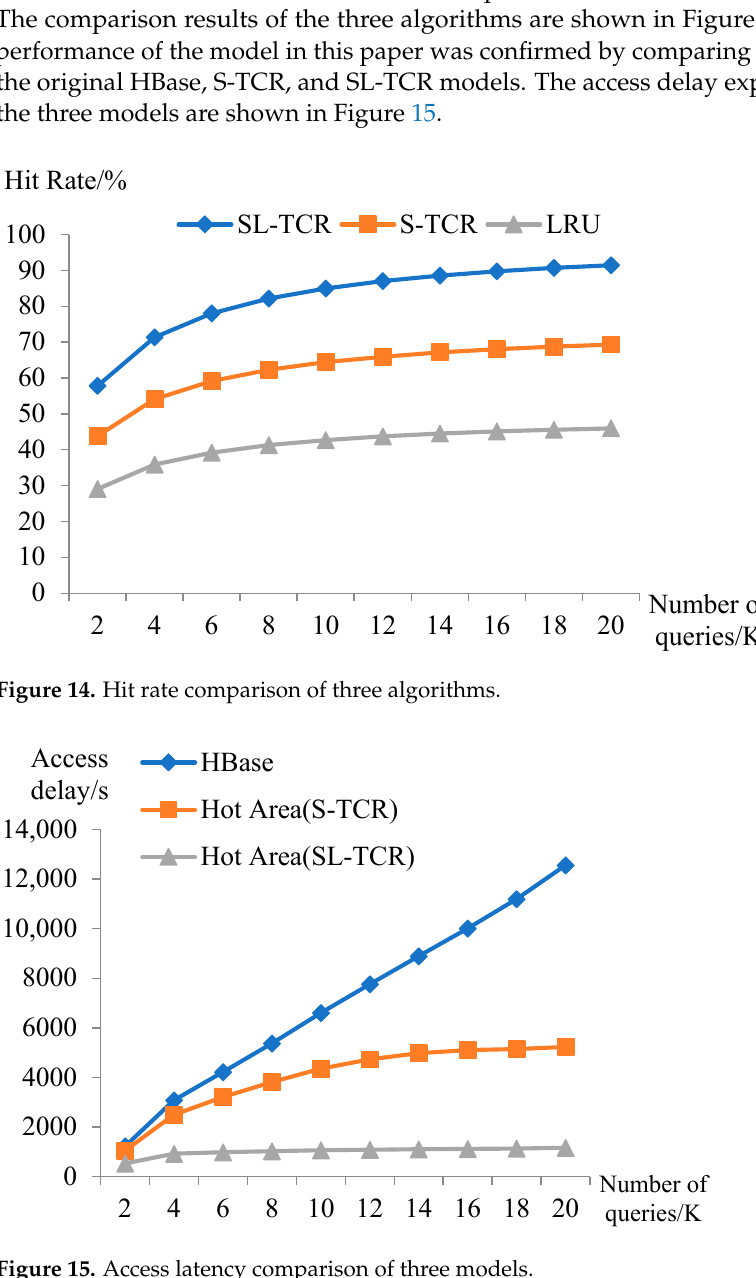
Figure 15. Access latency comparison of three models.